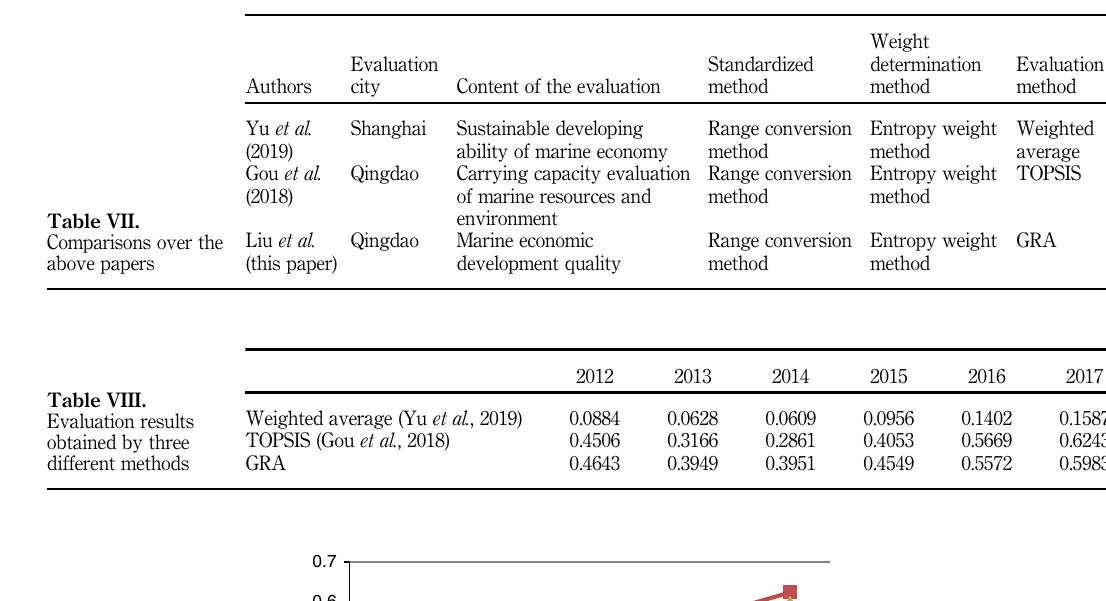
Figure 3. Comprehensive evaluation results of Qingdao marine economic development quality obtained by different